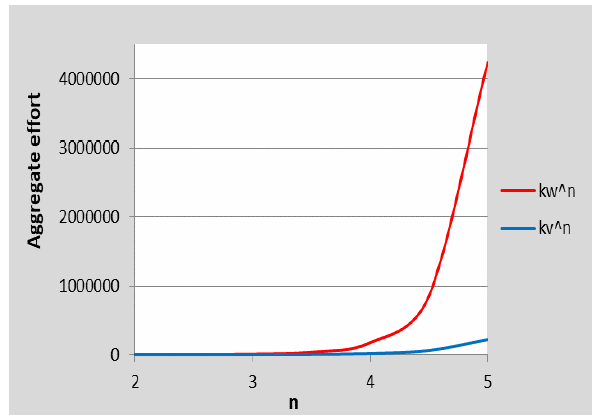
Figure 7. Final resources systems with its all resources with positive values.